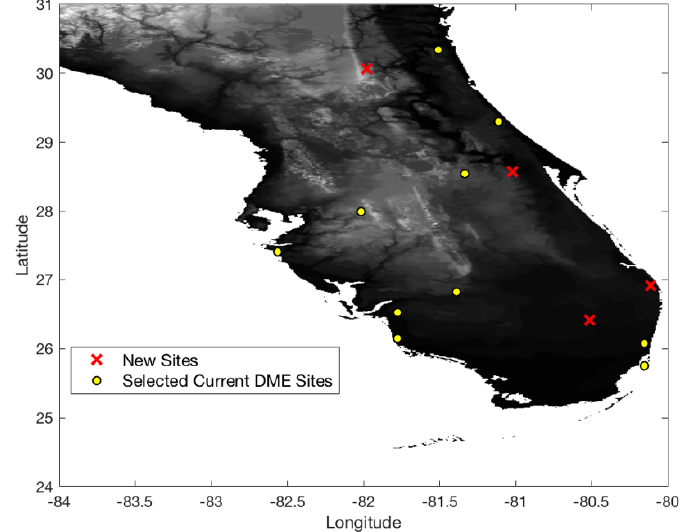
Figure 12. Optimal DME transponder network for 92.6 m positioning accuracy with DME/S.